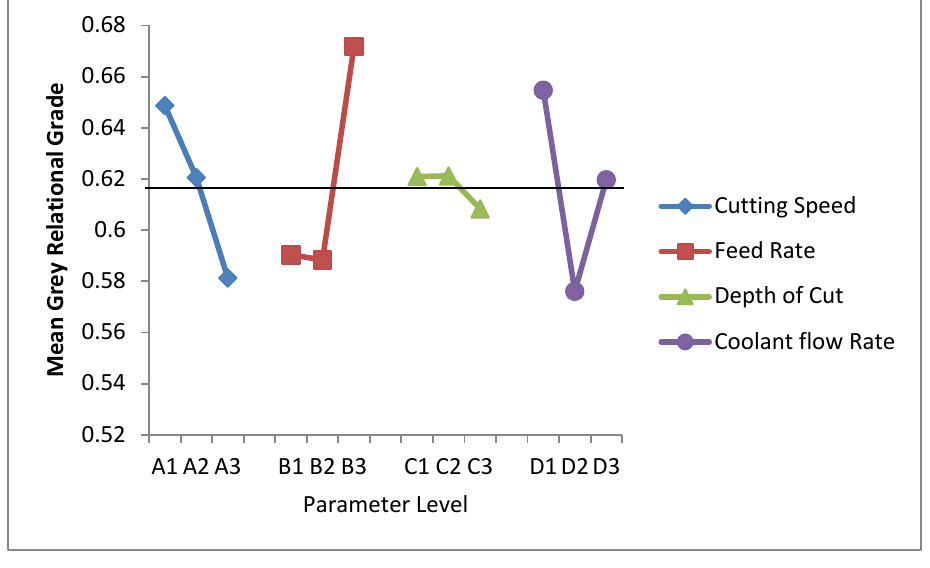
Fig. 4. Response graph of WSN ratio